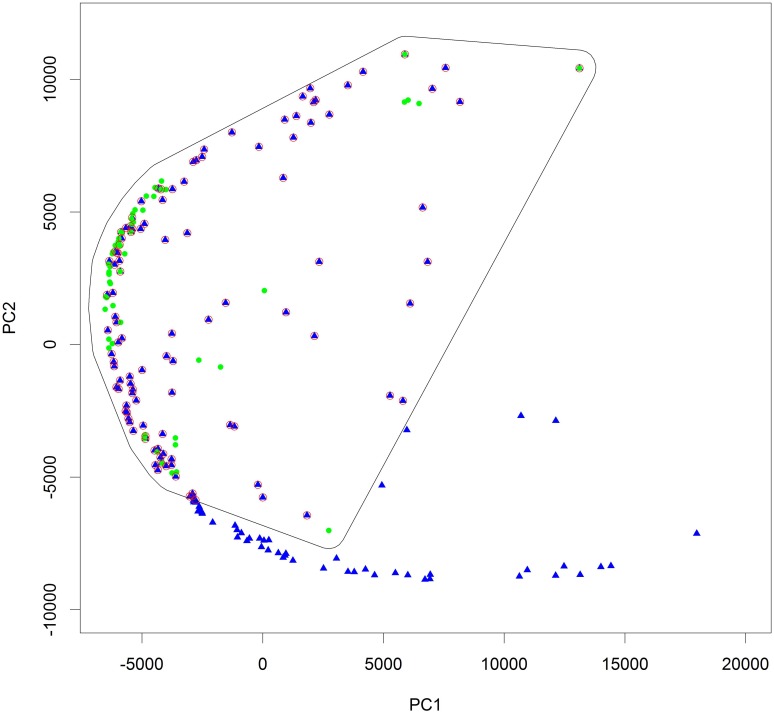
Principal component analysis of peach palm wild (var. chichagui) and domesticated (var. gasipaes) populations.As in Fig 1, green poins are the wild form (var. chichagui) and blue triangles are the cultivated form (var. gasipaes). The two components shown here explain 94% of the overall variation in the data. The polygon represents the convex hull area constructed around all var. chichagui points, extended with a 3% buffer of the largest hull axis.